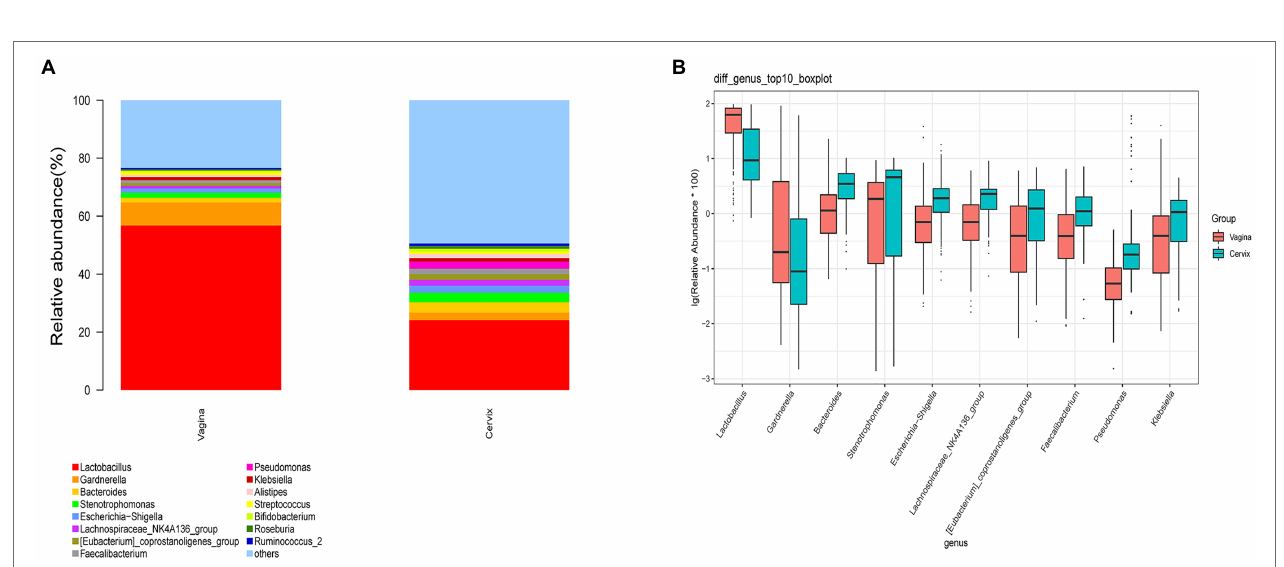
FIGURE 2 | The microbial composition of cervix and vagina and the different genera between the two sites. (A) The relative abundance of the top 15 genera at the genus level in the vaginal and cervical microbiota. (B) Boxplot of the top 10 genera in the differential genera between two